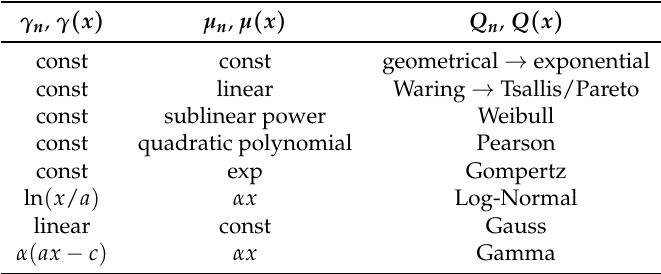
Table 1. Summary of rates and stationary PDFs